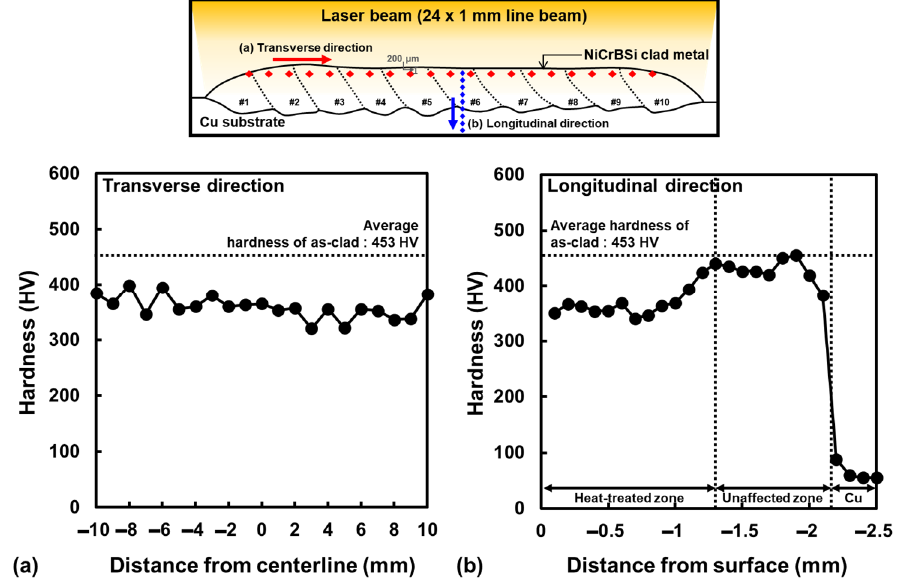
Figure 11. Hardness distribution along the ( a ) transverse and ( b ) longitudinal directions for the clad metal laser heat treated at 1323 K.